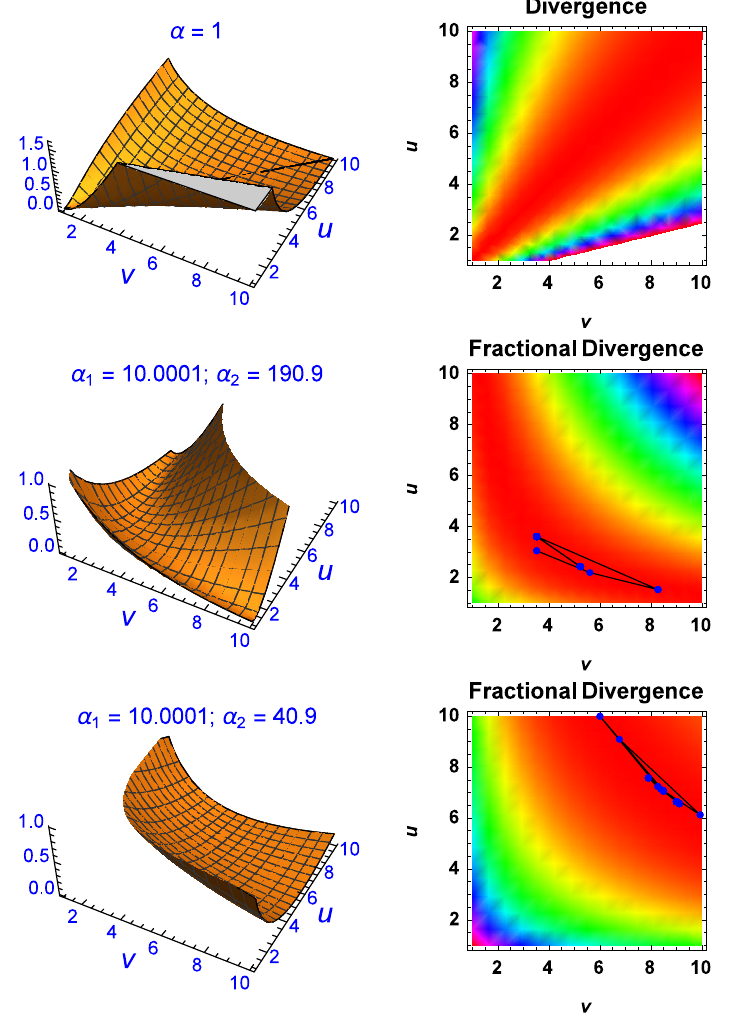
Figure 3. Variation of the (fractional) divergence manifold between two Exponential-densities in terms of the fractional orders α 1 and α 2 . The case α “ 1 corresponds to the conventional divergence. The conventional divergence is also shown on the right as an image map where the red region indicates small divergence on either side of the u “ v line (not shown). According to the conventional divergence between two Exponential-densities, the only solutions which give zero are those where u “ v . However, as the middle two and last two plots indicate, the fractional divergence can make the divergence between them zero or close to zero for regions (solutions) where the conventional version fails. The middle two figures show manipulation of the divergence manifold for α 1 “ 10.0001 and α 2 “